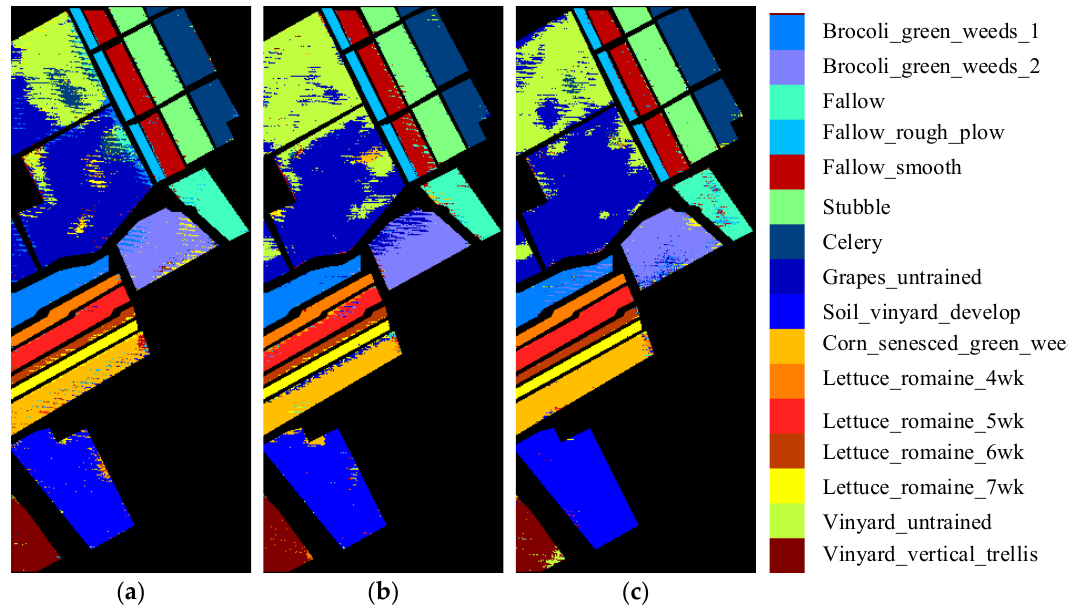
Figure 14. Classification maps on the SA dataset based on different number of training samples. ( a ) Sample = 5; ( b ) Sample = 10; ( c ) Sample = 15.